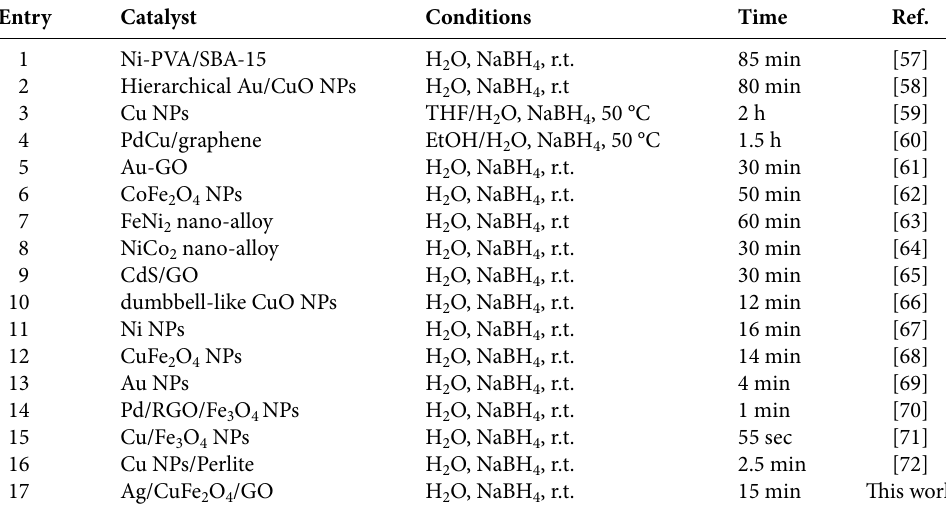
Table 1 . Comparison of the results obtained for the reduction of 4-NP in the present work with those obtained by some reported catalysts. Entry Catalyst Conditions Time